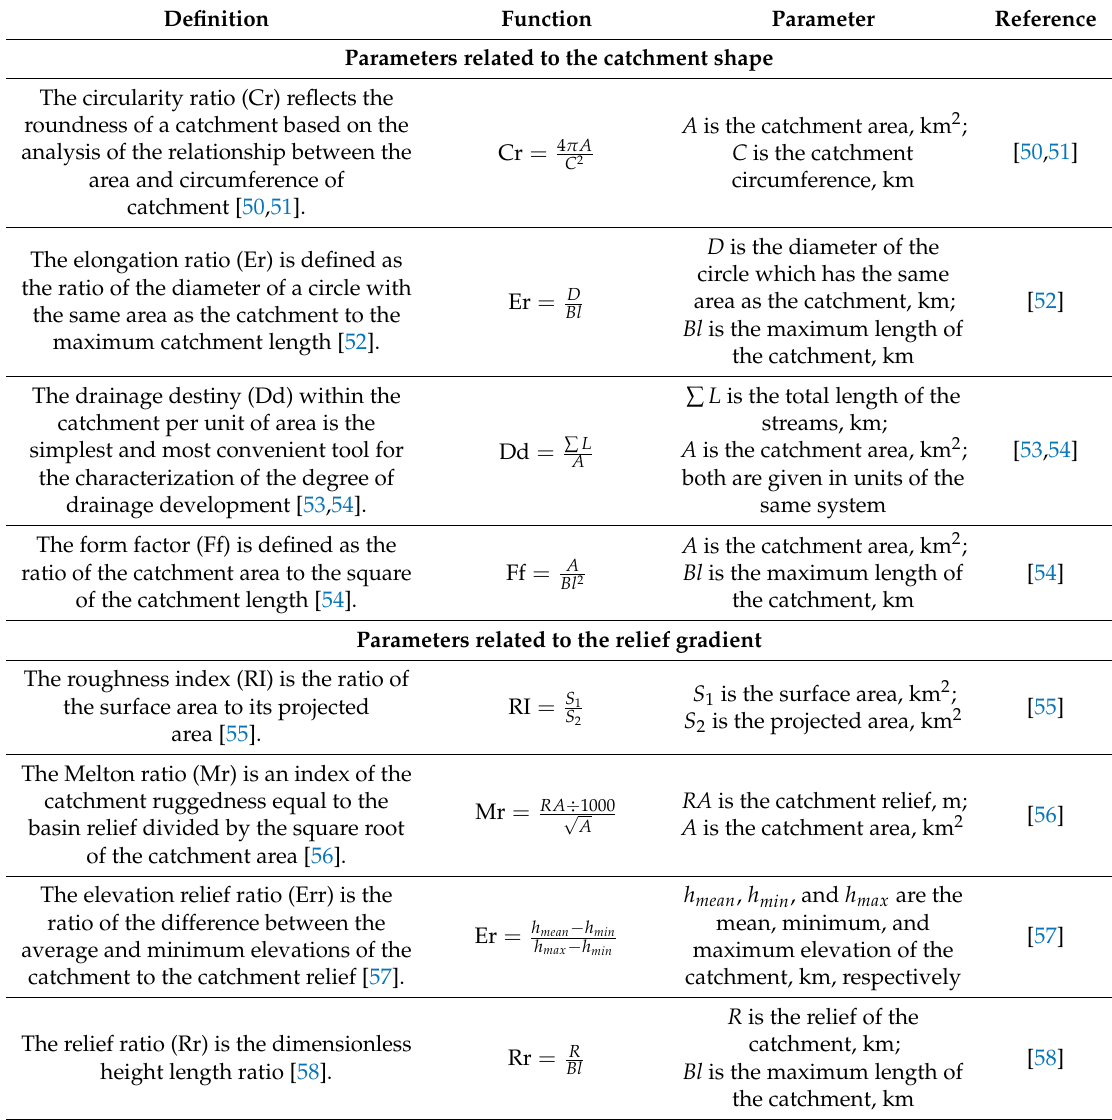
Table 2. Morphometric parameters related to the catchment shape and gradient